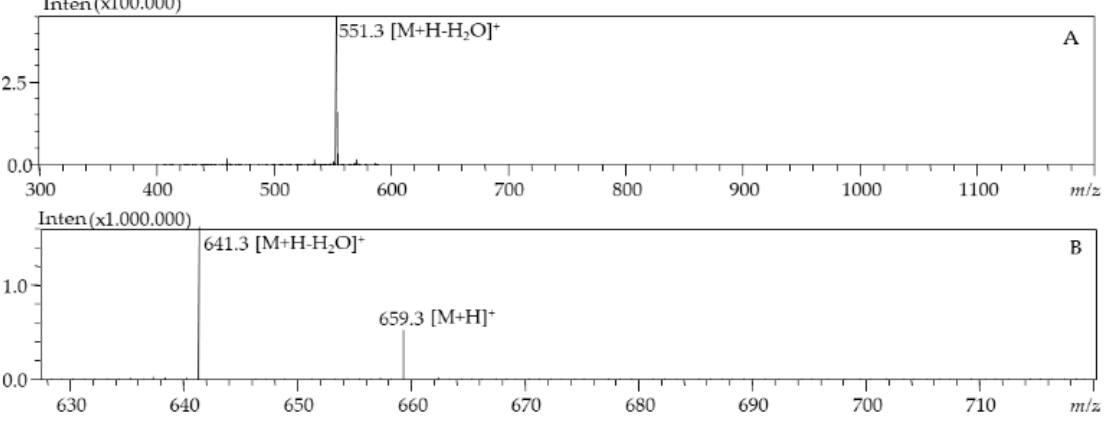
Figure 4. LC–MS (APCI + ) profile of lutein from Nannochloris sp ( A ) and fucoxanthin from P. tricornutum species ( B ).